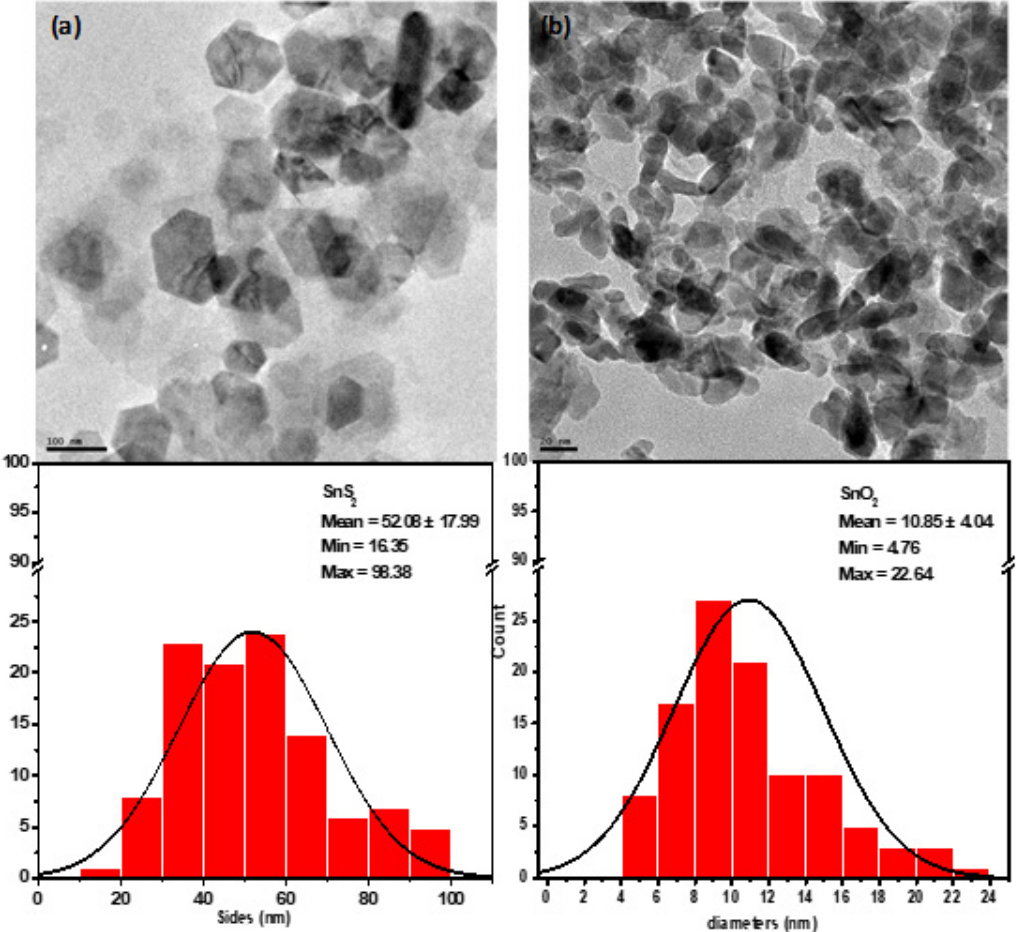
Figure 4. Transmission electron microscopy (TEM) images and histogram distribution plot of ( a ) SnS 2 (sides) and ( b ) SnO 2 (diameters) nanoparticles.